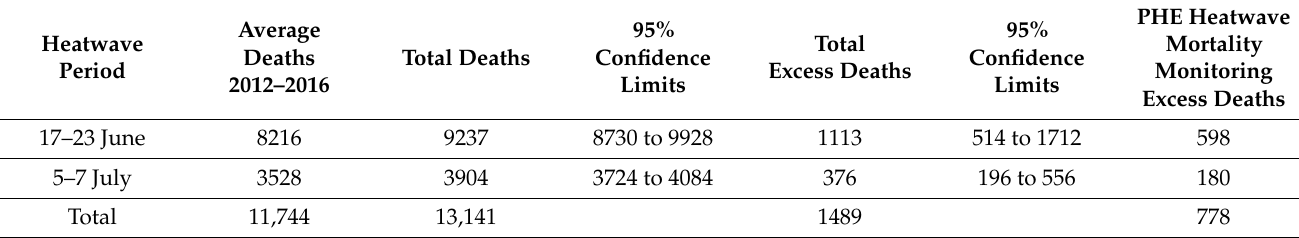
Table 3. Summer 2017 heatwave periods, the corresponding 5-year average of death occurrence for the same period and the excess number of deaths with 95% confidence intervals.